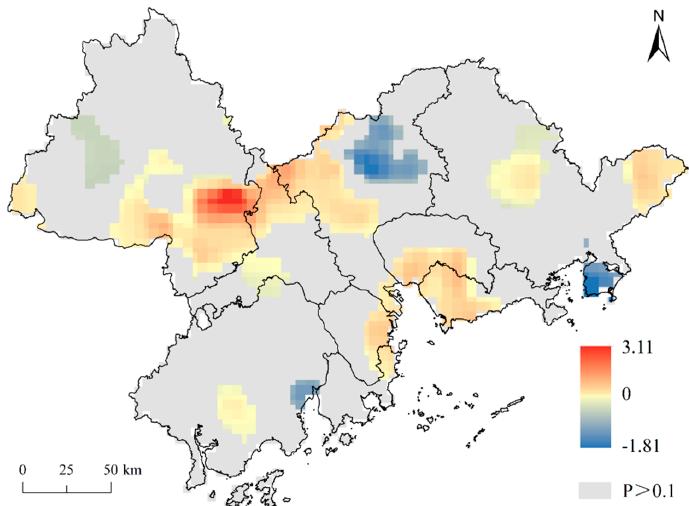
Figure 8. Spatial distribution of the regression coefficients ( p ≤ 0.1) of the recreational use of ecological land (RUoEL) on the ecological land restoration (ELR).